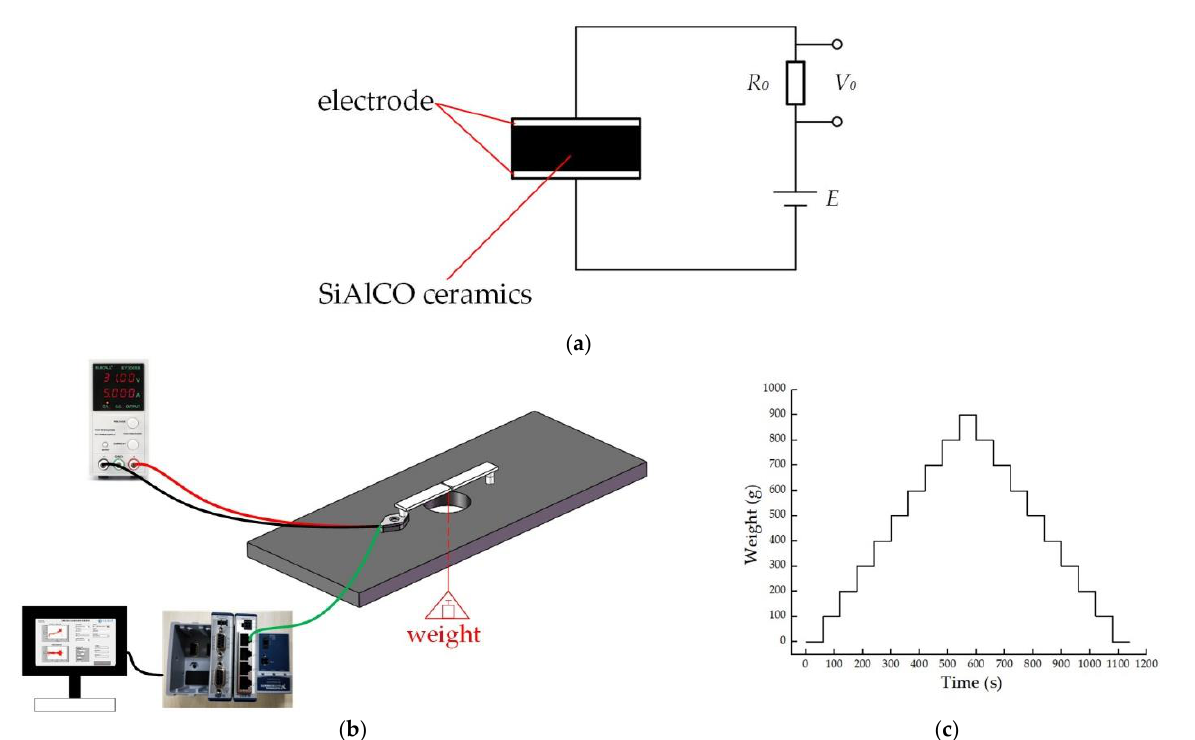
Figure 11. ( a ) The circuit schematic diagram of the test; ( b ) diagram of loading weights; ( c ) weight loading curve.